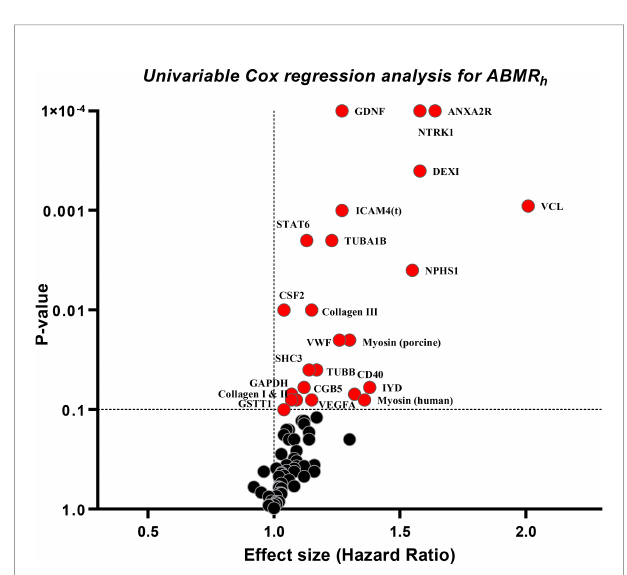
FIGURE 5 | Volcano plots for associations between the individual pretransplant non-HLA antibodies and the occurrence of ABMR h in the absence of HLA-DSA (N=774). The plot depicts the p-values and the Hazard ratios of the univariable Cox regression analysis for antibodies against 78 different targets. For three non-HLA targets, IL-21, Actin and FN1, no estimations were obtained from the Cox analysis due to the low number of positive patients. In this analysis patients were censored at the time of the last performed biopsy or at de novo HLA-DSA